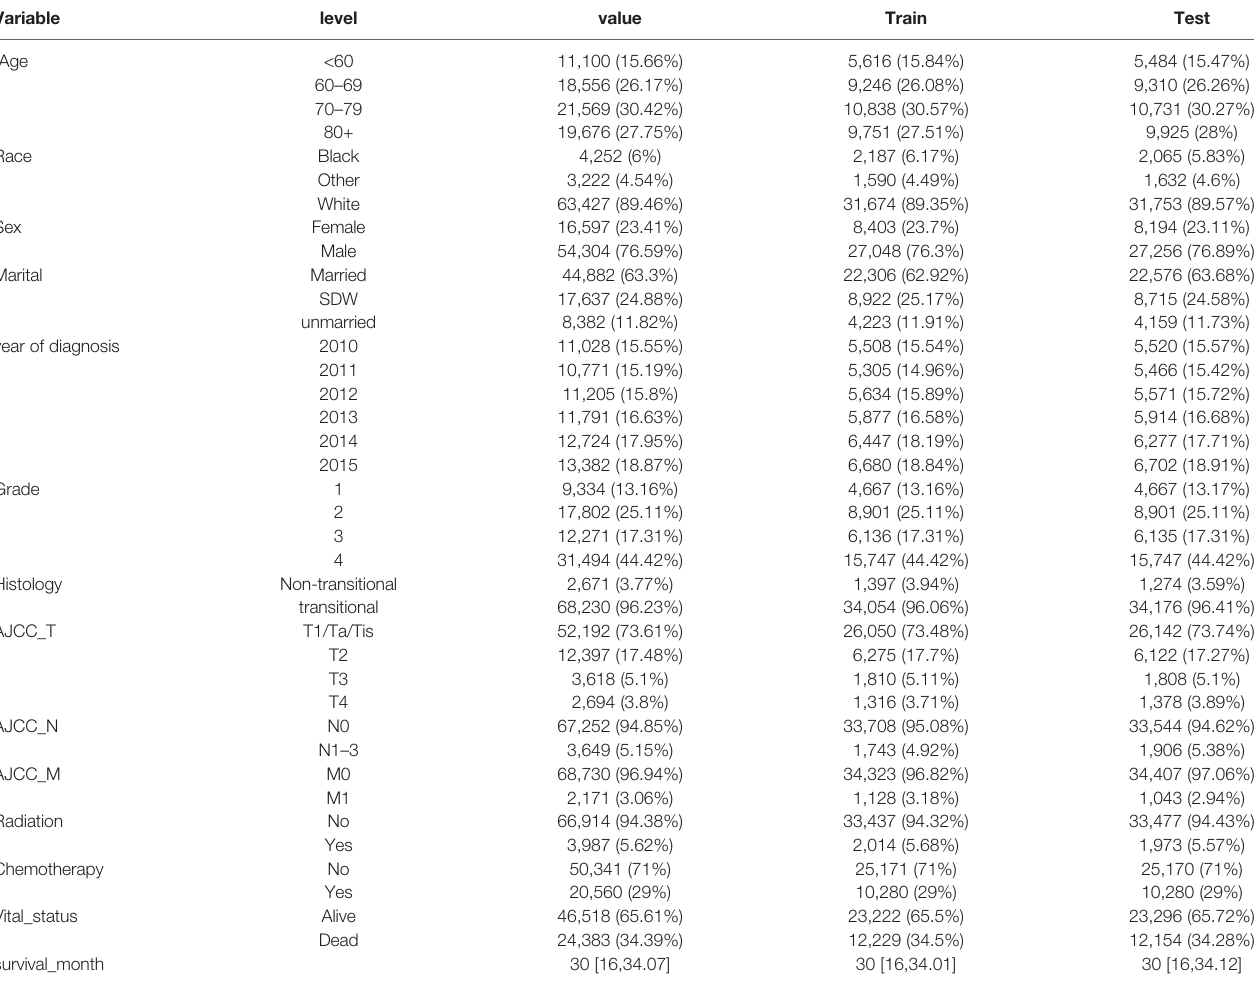
TABLE 1 | Counts and proportions on the characteristics of eligible BLCA